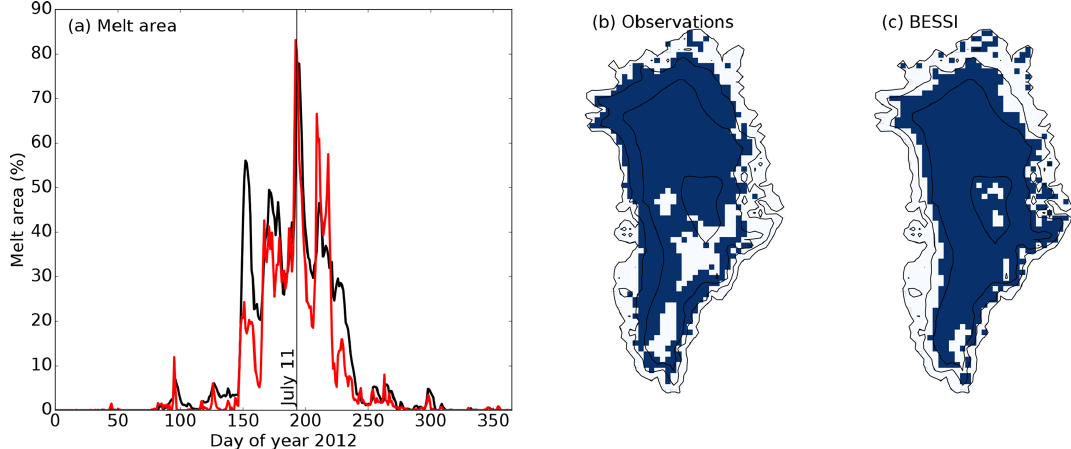
Figure 9. Melt extent of the year 2012, simulation BEST T . (a) Fractional melt area from observations (red) and BESSI (black), (b) observed melt area on 11 July, (c) same as panel (a) for BESSI.